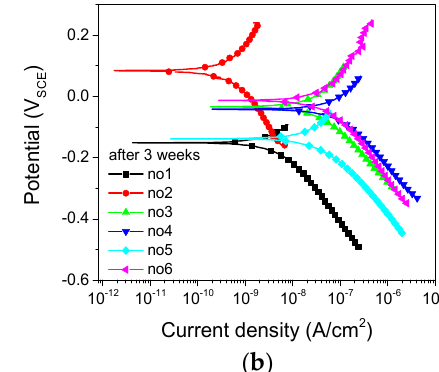
Figure 5. Polarization curves of Cu in inhibited antifreeze solutions measured ( a ) with as-prepared Cu specimens and solutions and ( b ) with Cu specimens and solutions used for 3 weeks of immersion test.